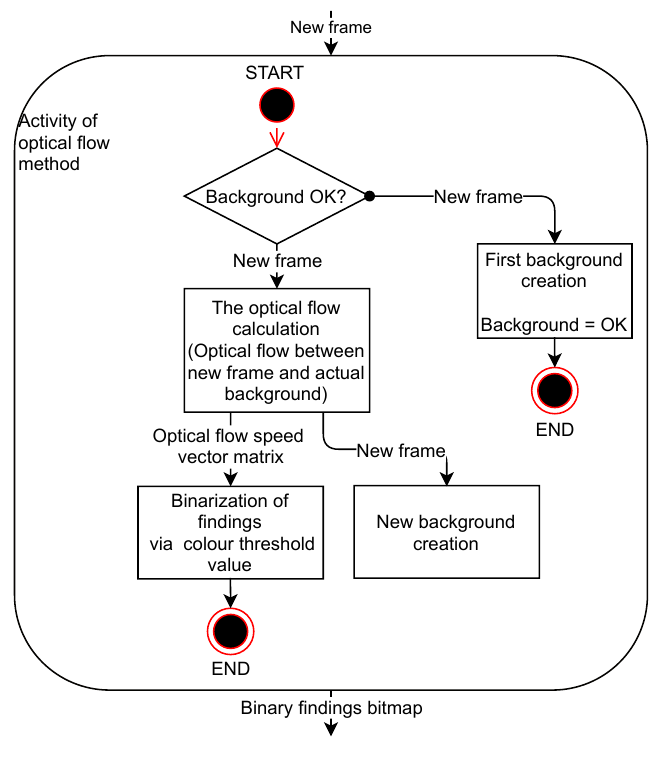
Figure 17. Diagram of optical flow method activity (Method 3).